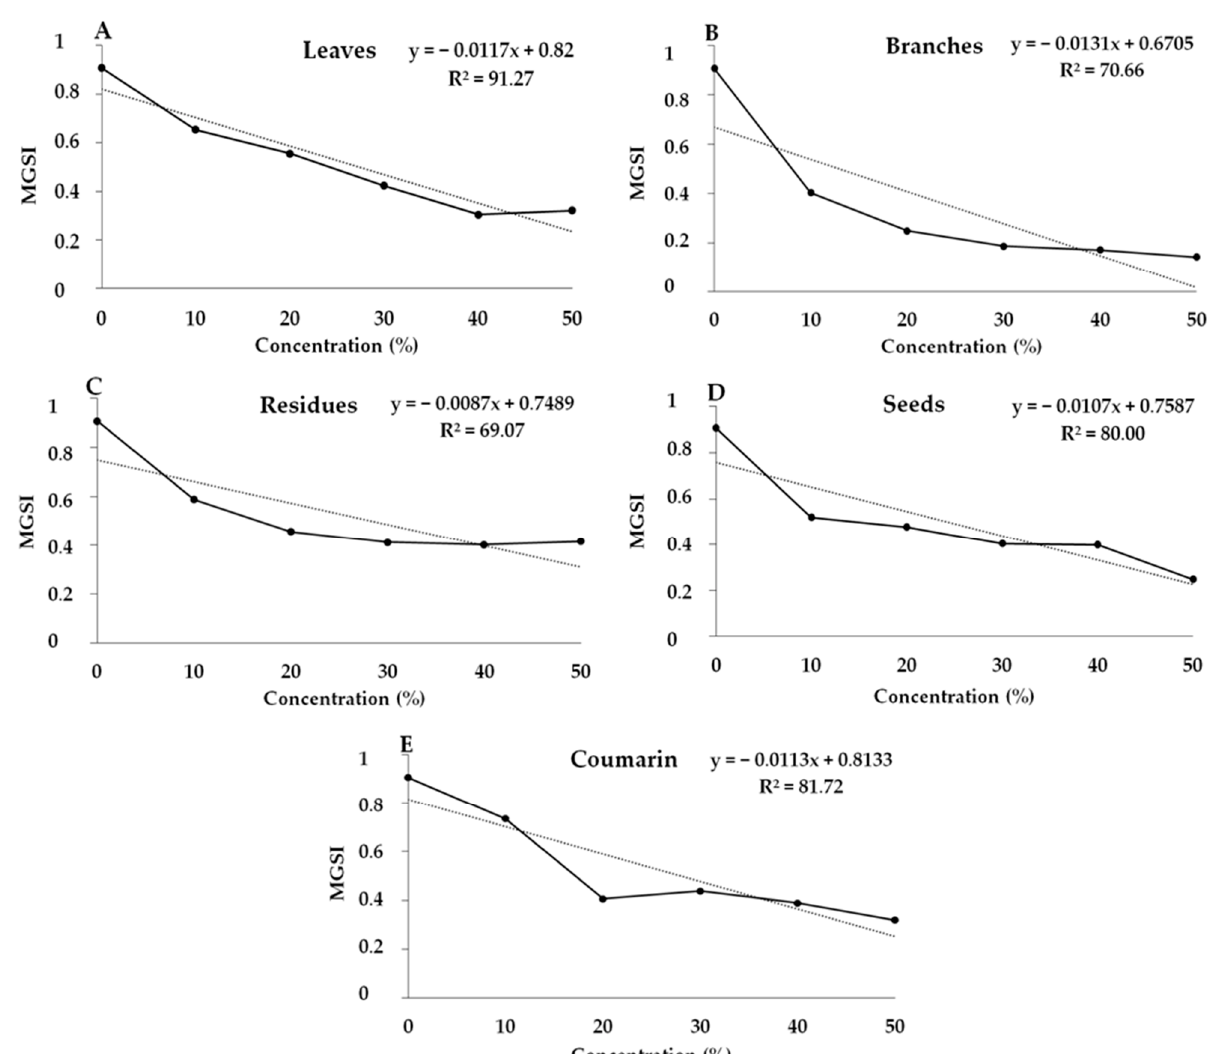
Figure 3. Regression analysis of the mycelial growth speed index (MGSI) of Colletotrichum musae subjected to different concentrations (10, 20, 30, 40, and 50) of the ethanolic extracts of Dipteryx punctata and the coumarin standard. ( A ) Extract from the leaves. ( B ) Extract from branches. ( C ) Extract from residues. ( D ) Seed extract. ( E ) Coumarin standard.